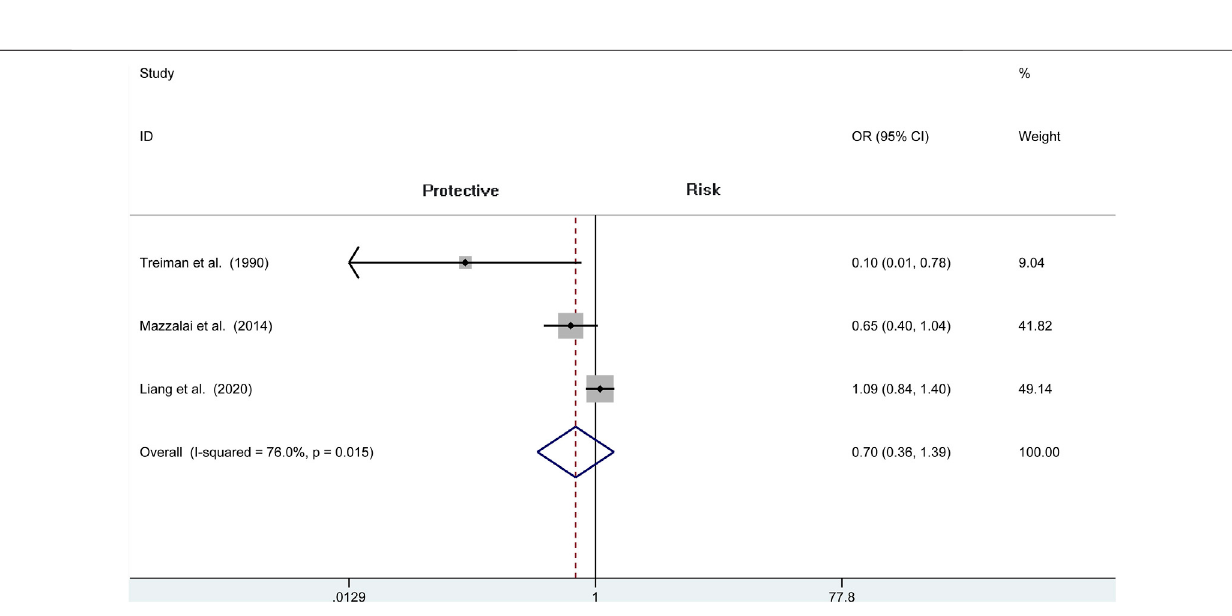
Frontiers in Pharmacology |